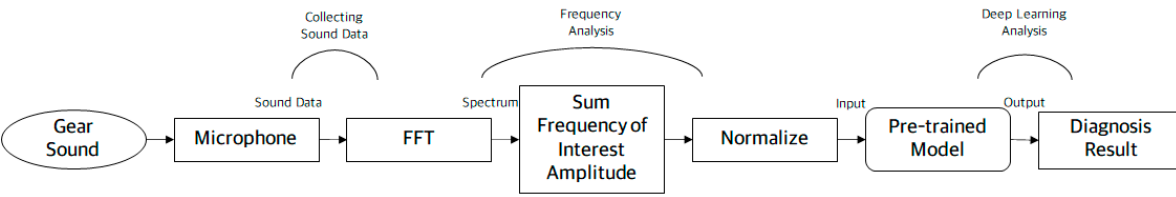
Figure 2. The overall flow of the gear’s defect diagnosis system.